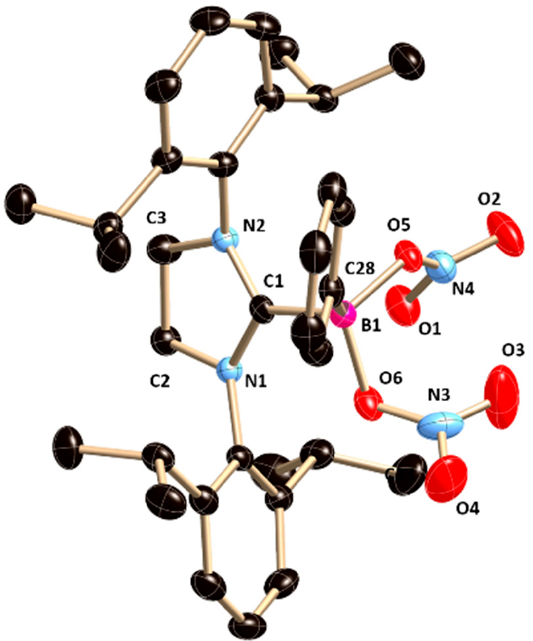
Figure 6. The molecular structure of 6 . Hydrogen atoms are omitted for clarity. Selected bond lengths [Å] or angles [deg]: N1 − C1 1.337(3), C1 − N2 1.340(3), N1 − C2 1.480(3), N2–C3 1.484(3), C1–B1